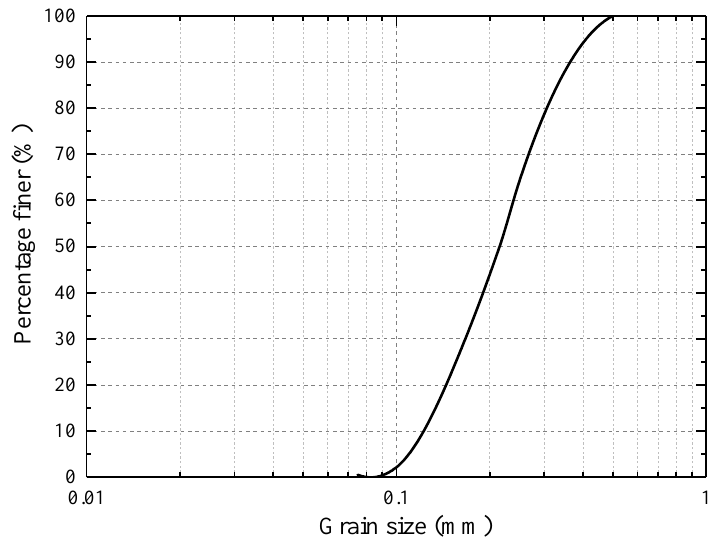
Figure 5. Grain-size distribution of soil sample: d 50 = 0.215 mm, d 10 = 0.081 mm, d 30 = 0.167 mm, d 60 = 0.239 mm; c u = 2.972, and c c = 1.448.